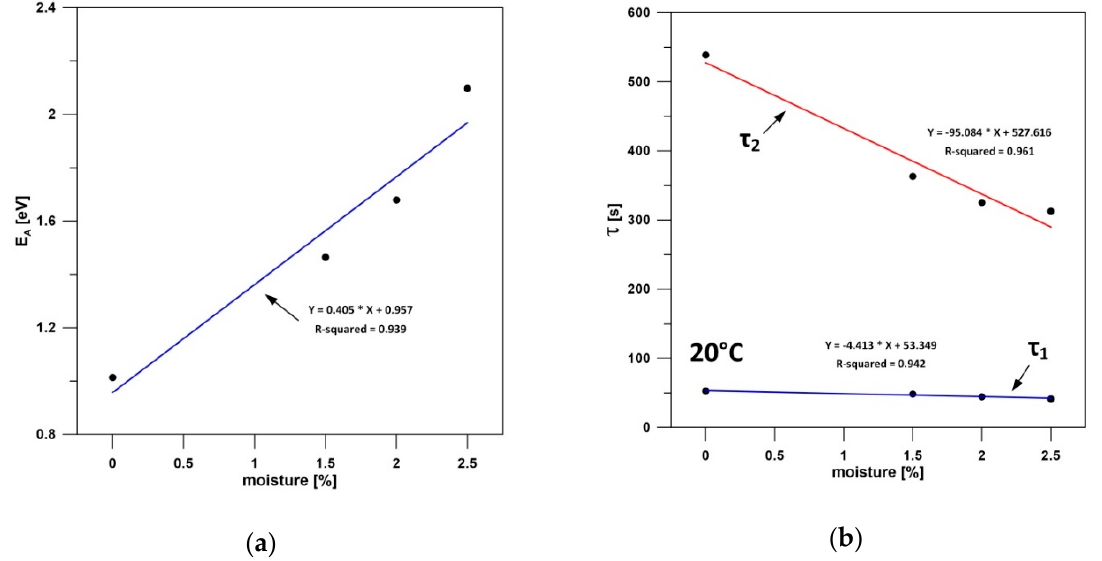
Figure 11. Dependence of the activation energy E A ( a ) and dominant time constants τ 1 and τ 2 ( b ) on the degree of moisture for a selected non-aged cellulose–aramid insulation sample.